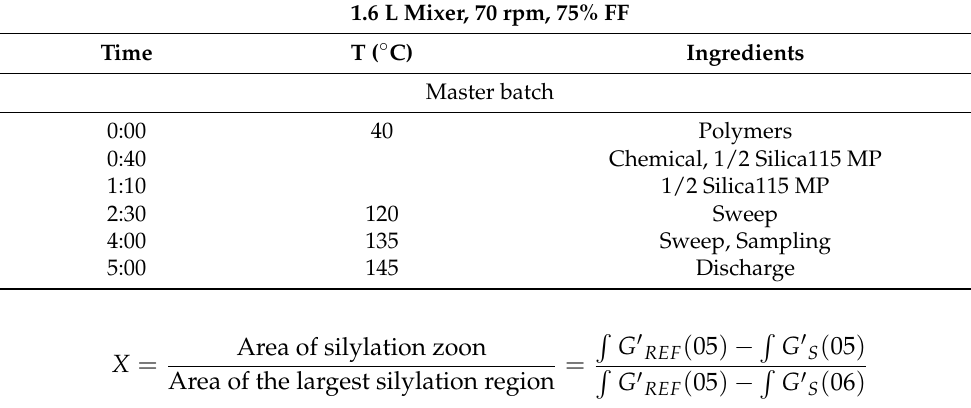
Table 2. The preparation process of the mixed rubber.